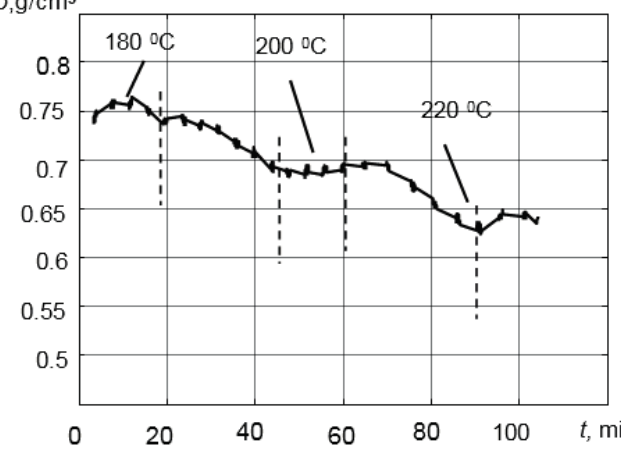
Figure 15. Variations of the density of the virgin polypropylene melt at different